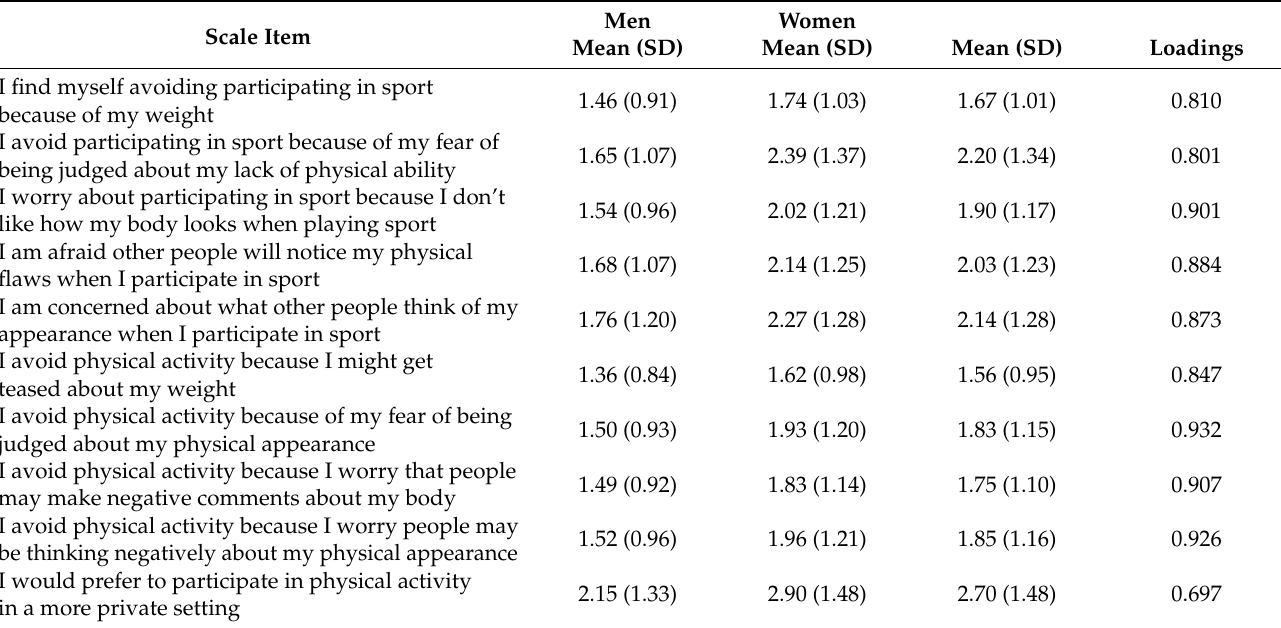
Table 2. Scale items and factor loadings of TAPAS.